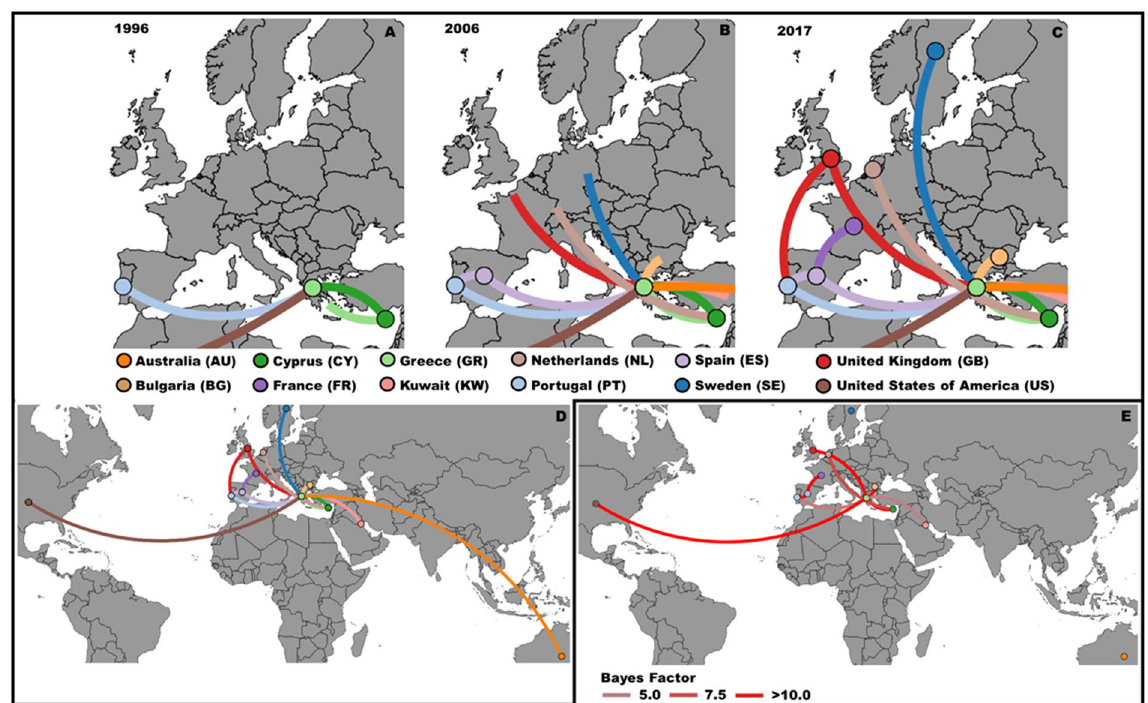
Figure 3. Phylogeographic evolution of the Main A1 clade. Geographical display of the phylogeny built using BEAST with the country of the sequence origin as discrete trait. ( A ) In the year of 1996 this transmission history reached Western Europe, arriving to Portugal. ( B ) After a decade, in 2006, viruses from this clade are expected to be found in several countries from different geographic regions. Some countries, like Portugal, started now being donors and not only receivers in this transmission history. ( C ) In 2017 the spread among several European countries is established. ( D ) Global representation of this transmission history; (E) Rates between country pairs with Bayes Factor superior to